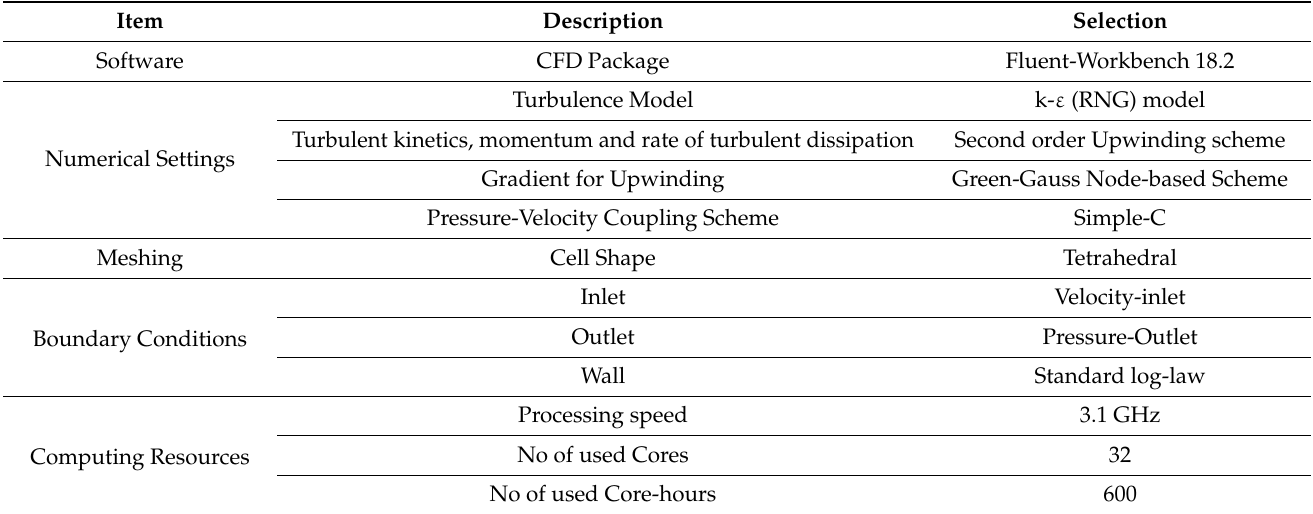
Table 1. Characteristics of the CFD